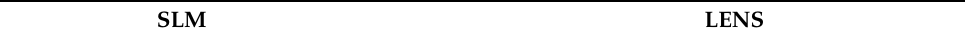
Table 1. Comparison between Selective Laser Melting (SLM) and Laser Engineered Net Shape (LENS) processing of Nitinol